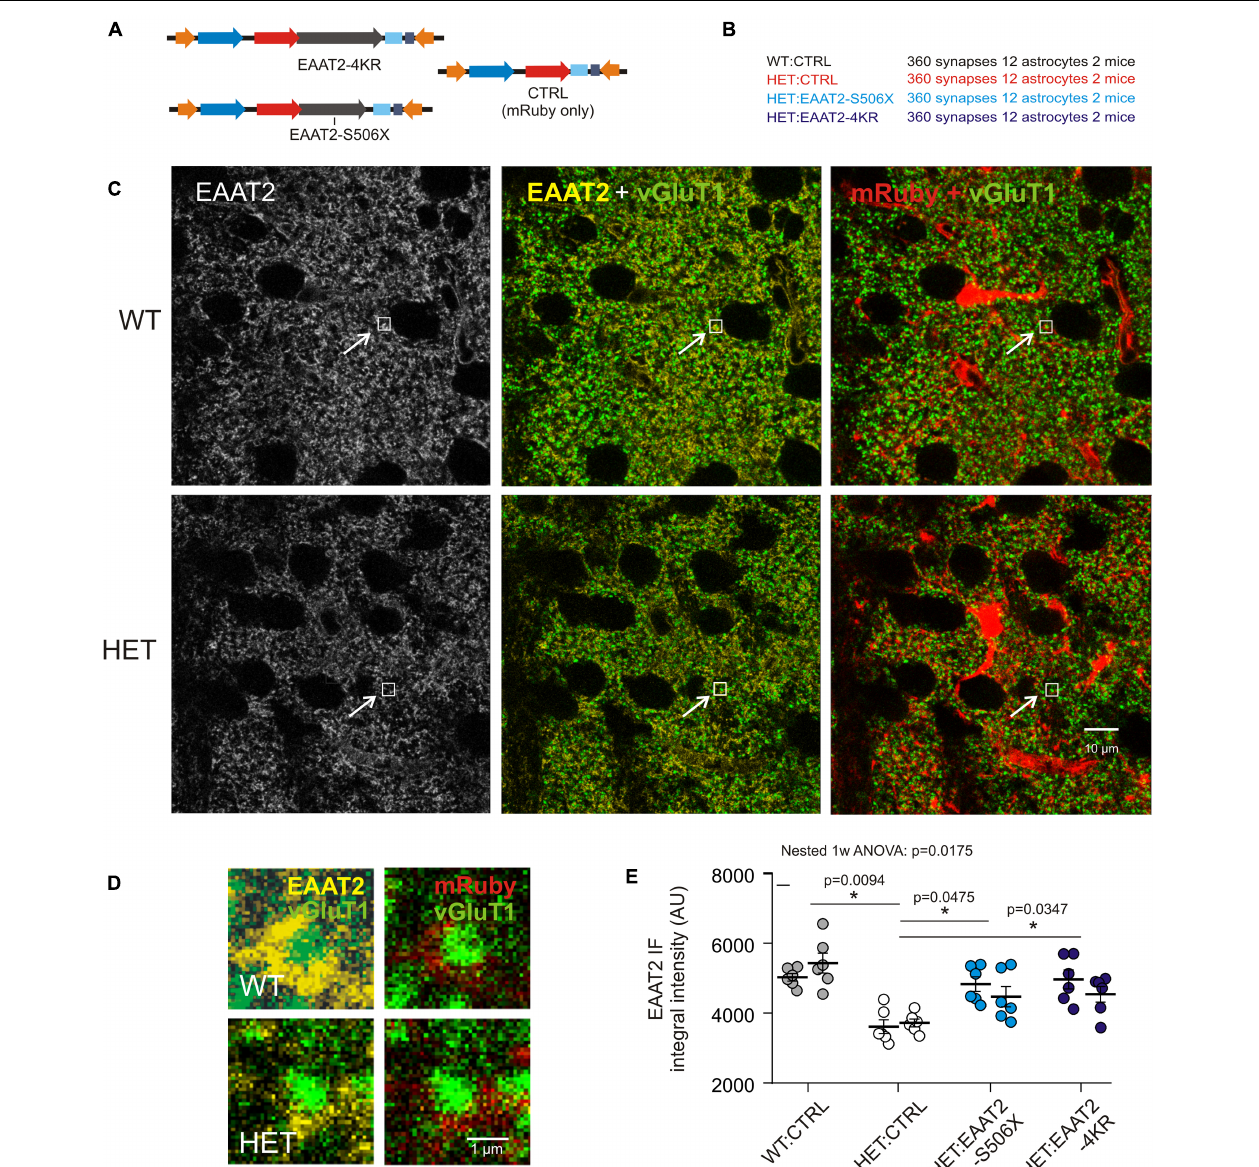
FIGURE 4 | Evaluation of synaptic EAAT2 immunofluorescence in fixed sections. (A) Injected vectors. (B) Animal groups. (C) Confocal images from WT:CTRL and HET:CTRL to illustrate the mHTT-related decrease in the overall EAAT2 IF. In the illustrated samples the mean intensity values were 3078 ± 38.4 (WT:CTRL) and 2673 ± 31.7 (HET:CTRL). (D) Regions of interest (ROIs) comprising just one synapse. The ROIs correspond to the small boxed areas in (C) . The EAAT2-immunopositive area corresponds to an astrocyte perisynaptic process (PAP), as it is labeled with mRuby. (E) Quantification of integral EAAT2 IF from ROIs comprising only one vGluT1-immunopositive terminal. Numbers in brackets: evaluated synapses per group. Each data point is the mean value from 30 synapses on 1 mRuby-labeled astrocyte. Separate plot of data from the 2 animals per group. * p < 0.05 or 0.01.